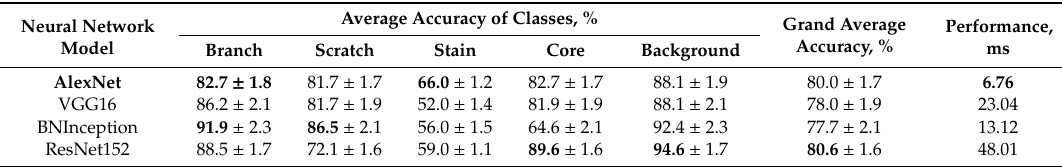
Table 3. Accuracy classification when using AlexNet, VGG16, BNInception, and ResNet152 neural network models for transfer learning. The best results are shown in bold.